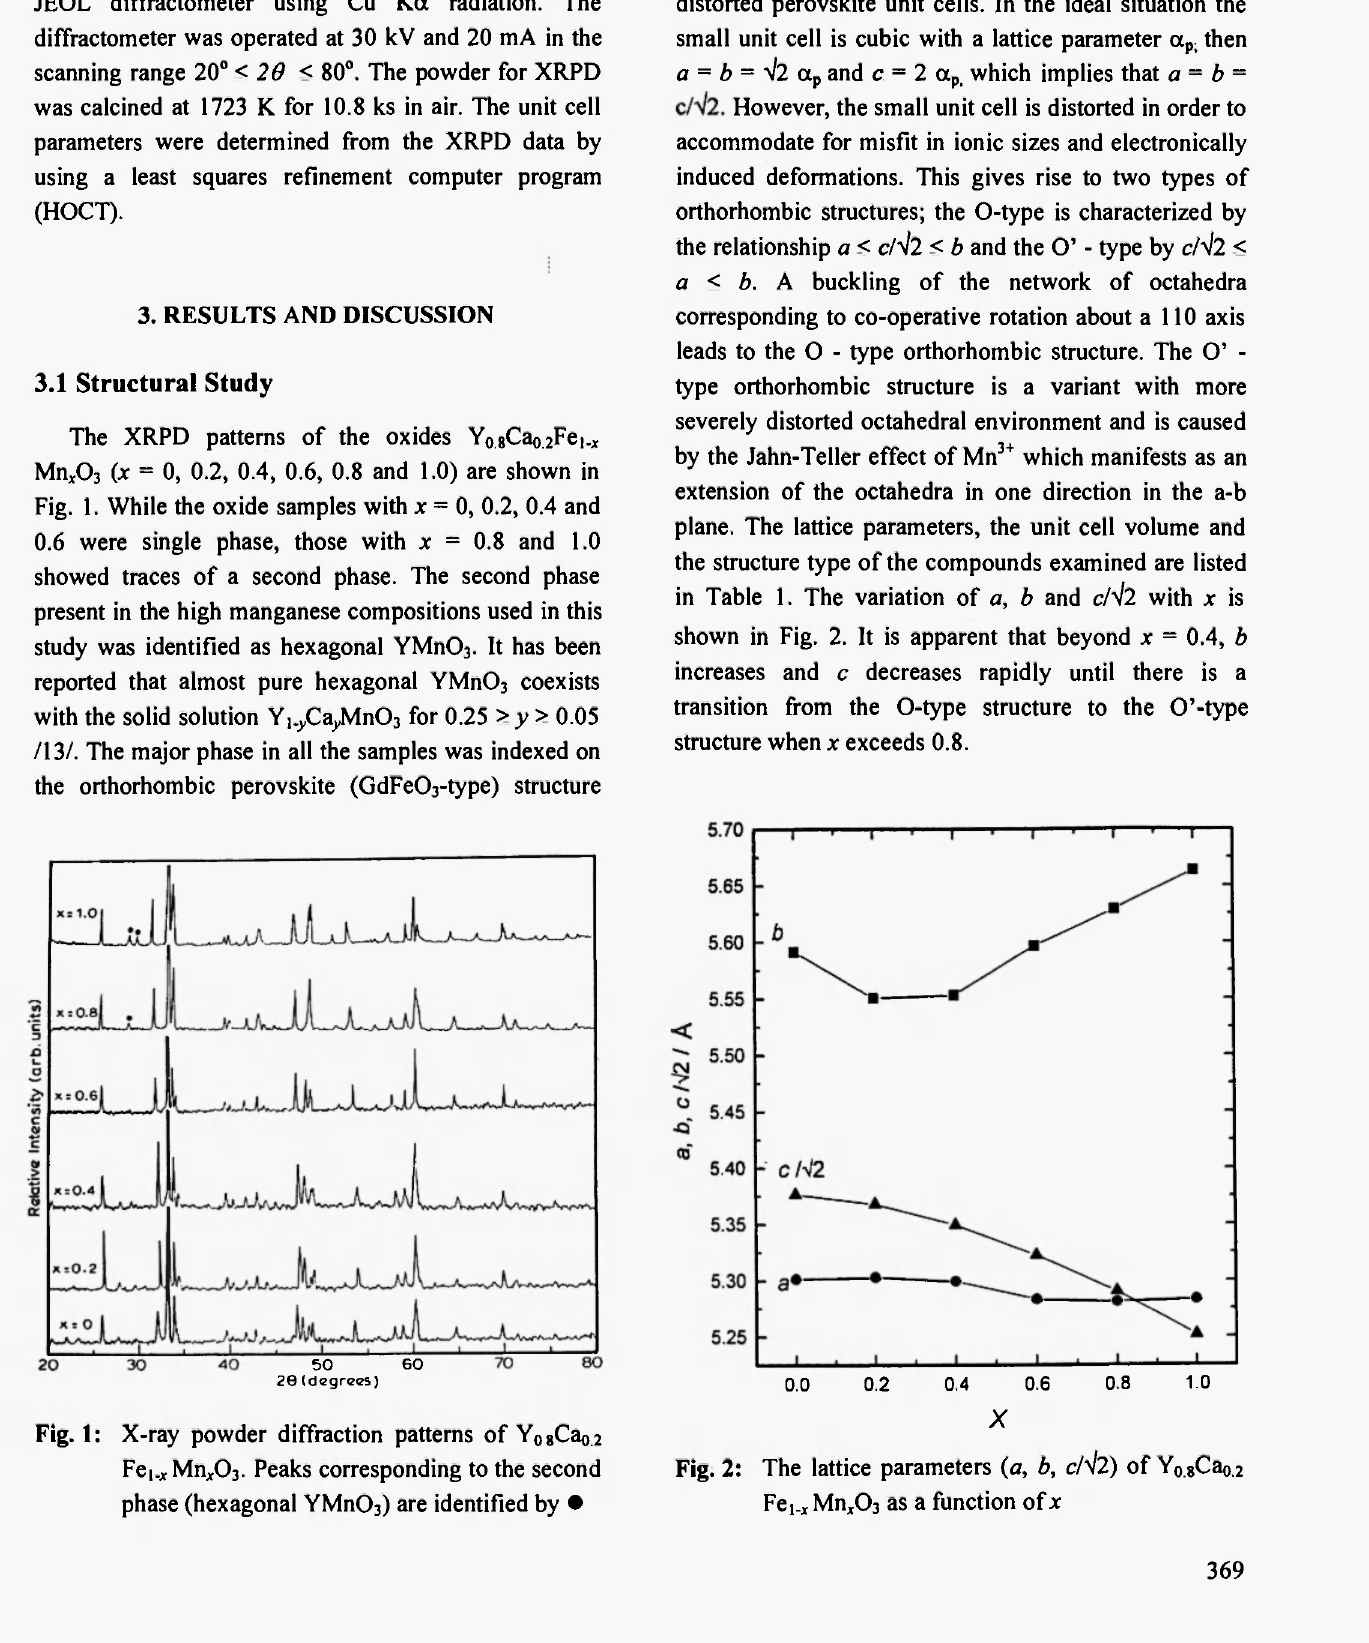
Fig. 2: The lattice parameters ( a , b, cN 2) of Yo.gCao.2 Fej.j Mn x 0 3 as a function of